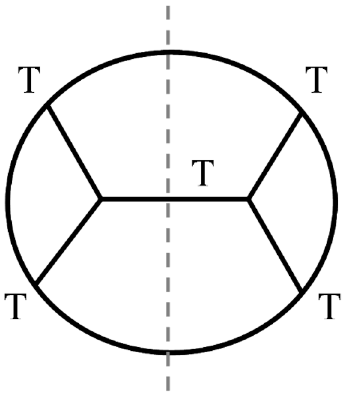
Figure 6 . The tree-level exchange diagram for the N = 4 stress tensor